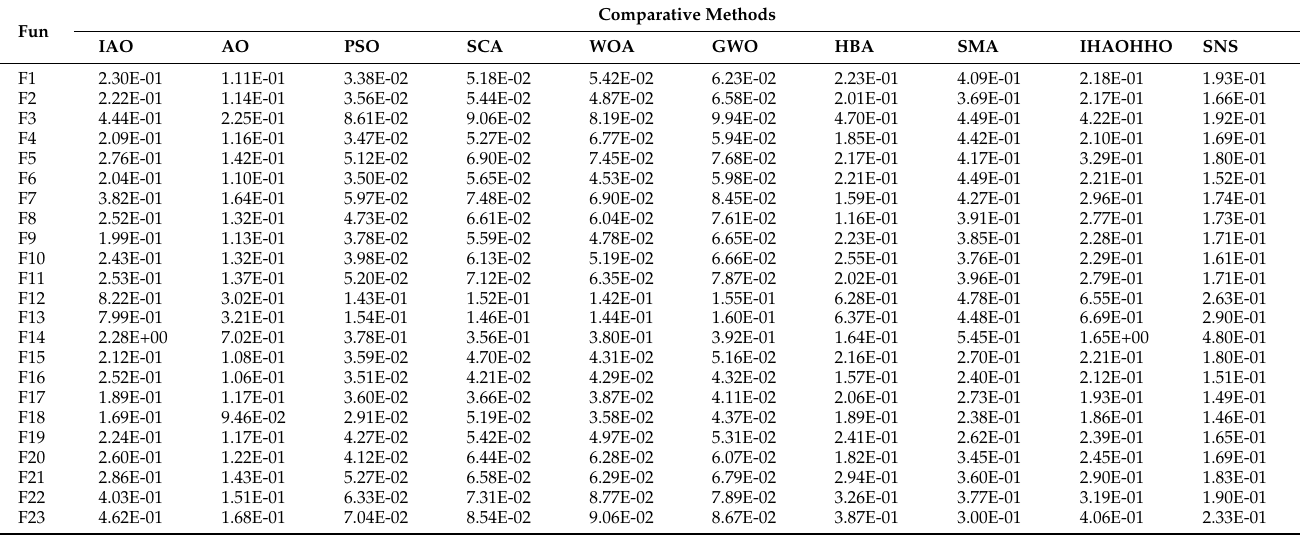
Table 10. Computation time of algorithms on benchmark